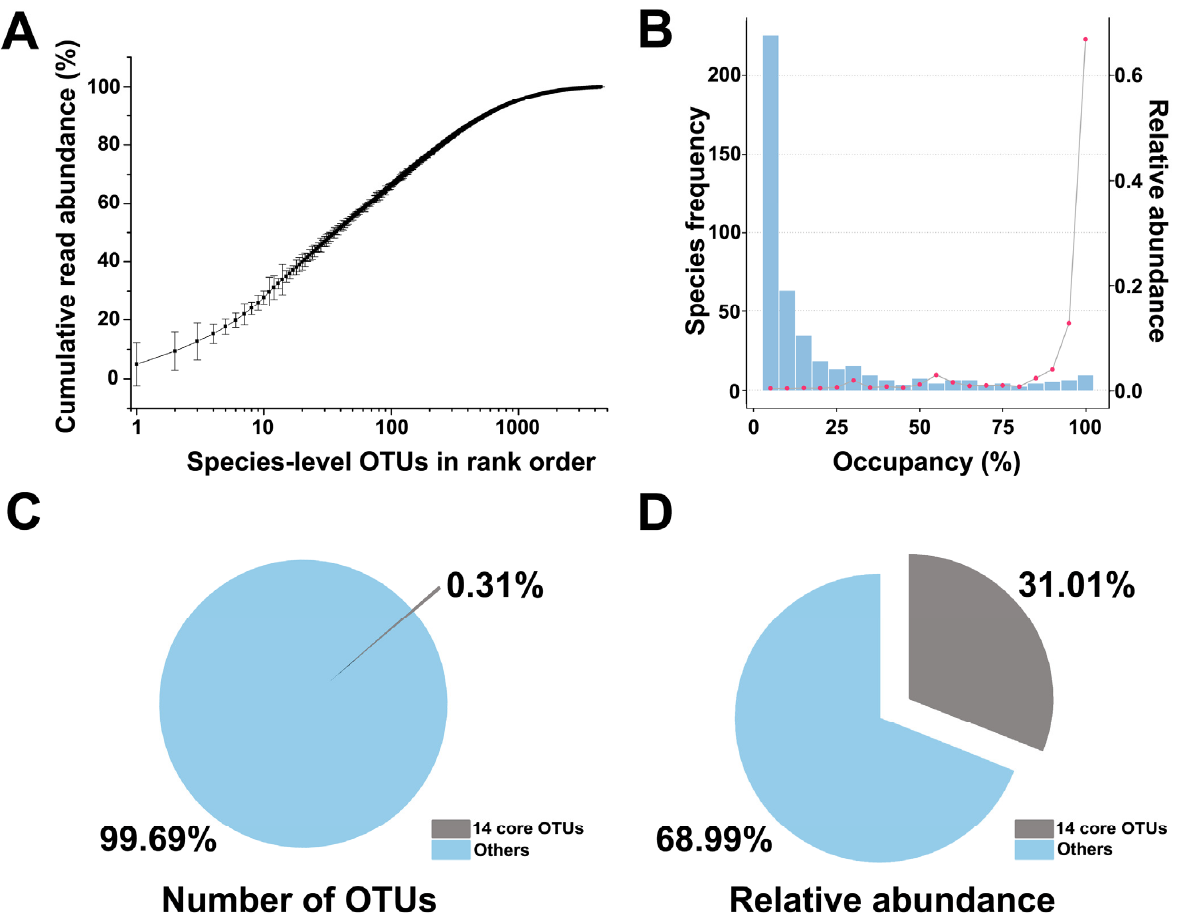
Figure 3. Core bacterial community. ( A ) Cumulative read abundance across the 78 samples. Cumulative read abundance (mean ± SD) of species-level OTUs plotted in rank order for the 78 samples. In each sample, the 10 most abundant OTUs made up 27.78% (±2.26%) of the total reads on average, and the 100 most abundant OTUs made up 66.32% (±0.34%). OTUs were considered “abundant” in a sample when they were among the OTUs comprising the top 80% of reads. ( B ) Frequency and abundance distributions of all OTUs. OTUs were classified into bins according to their occupancy of samples. For example, the first bin contains OTUs detected in fewer than 5% of the samples, while the last bin contains OTUs detected in 95–100% of the samples. Species frequency (the number of OTUs) is indicated by the blue bars; the total abundance of OTUs in each bin is indicated by the red points. ( C , D ) Percentage and relative abundance of the core OTUs versus the remaining microbial OTUs. In total, 0.31% (14 of 4473 OTUs) OTUs were identified as abundant and frequent at the countrywide scale; these OTUs accounted for (on average) 31.01% of the 16S rRNA gene sequences of all samples.